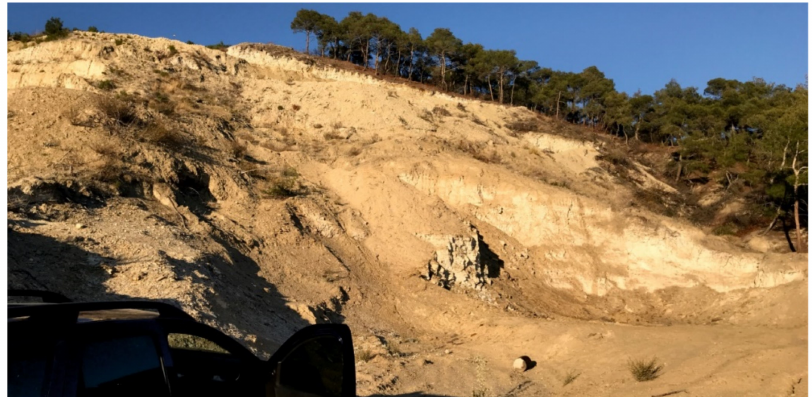
Figure 3. Quarry view of the Sarayköy (Denizli-Turkey)